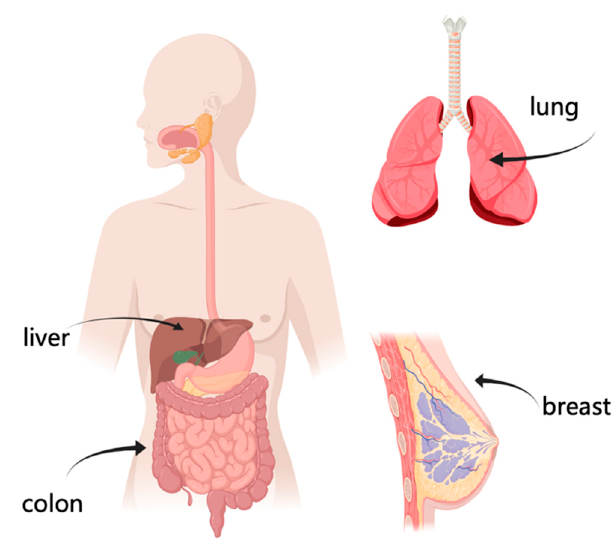
Figure 4. The human organ anatomy diagram includes breast, colon, lung, and